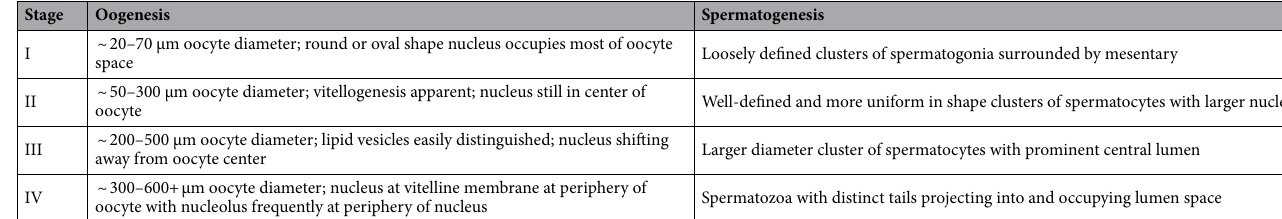
Table 1. Histological developmental stage classification for gametogenesis in M. capitata and M. flabellata 59,62–64 .